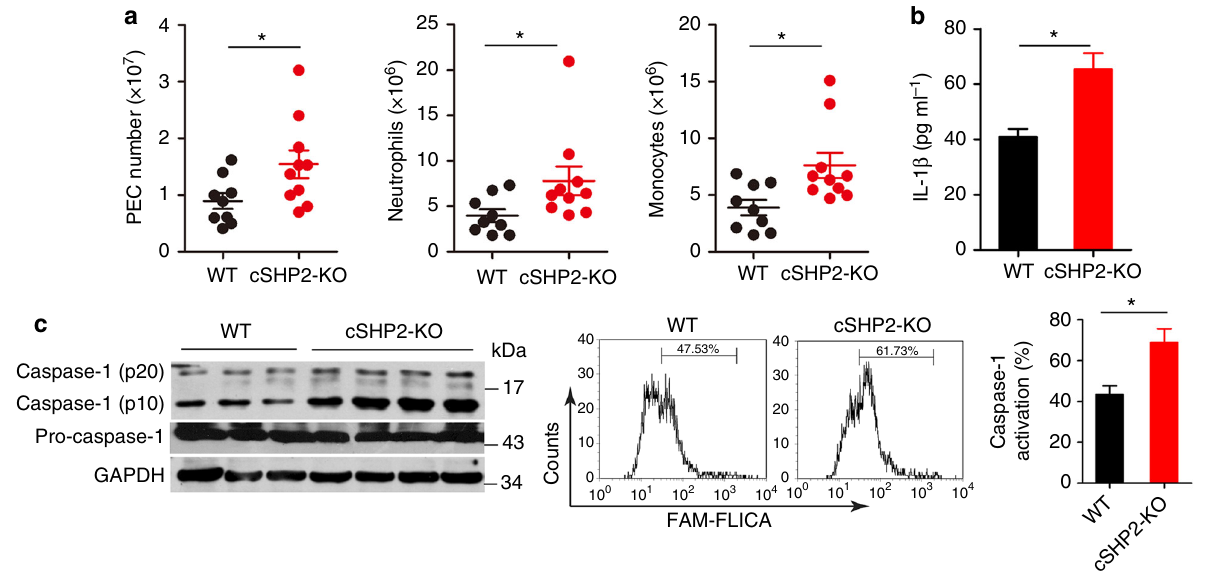
Fig. 2 SHP2 de fi ciency in macrophages aggravates murine peritonitis model. a – c Eight-week-old female cSHP2-KO and WT mice were killed 12 h after Alum injection and peritoneal cavities were washed with PBS. a Flow cytometry analysis of peritoneal exudate cells (PECs) 12 h after Alum injection in mice. b ELISA of IL-1 β level in the lavage fl uid 8 h after Alum injection in mice. c Immunoblot analysis (left panel) and fl ow cytometry analysis (right panel) of caspase-1 activation in PECs 12 h after Alum injection in mice. Data are representative of three independent experiments (mean and SEM of 10 mice per group), * P < 0.05 by Student ’ s t